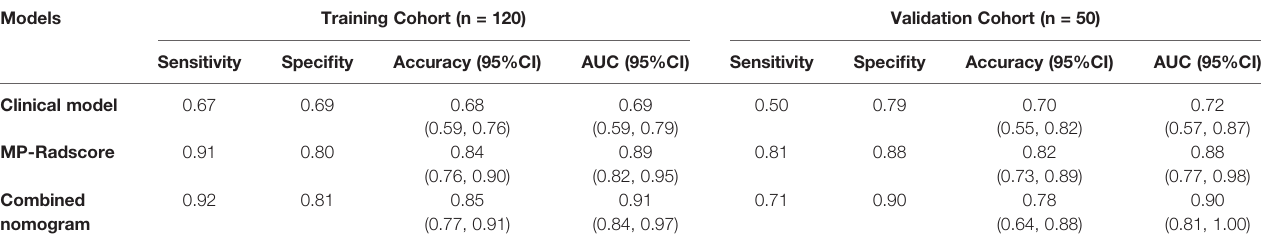
TABLE 3 | Diagnostic performance of models in the training and validation cohorts.